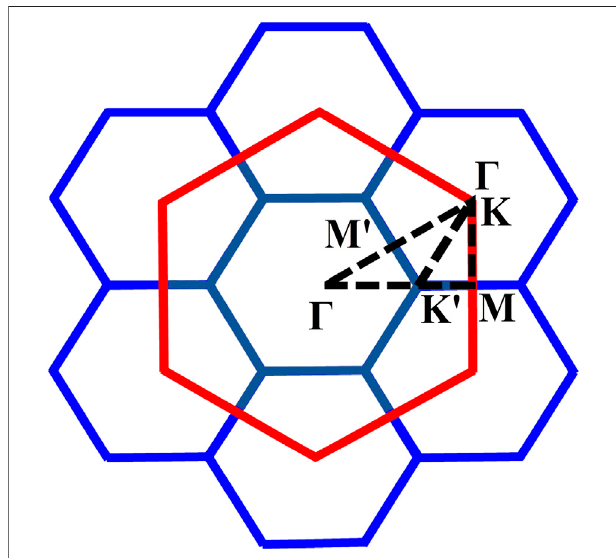
FIGURE 2 | Brillouin zone folding for silicene